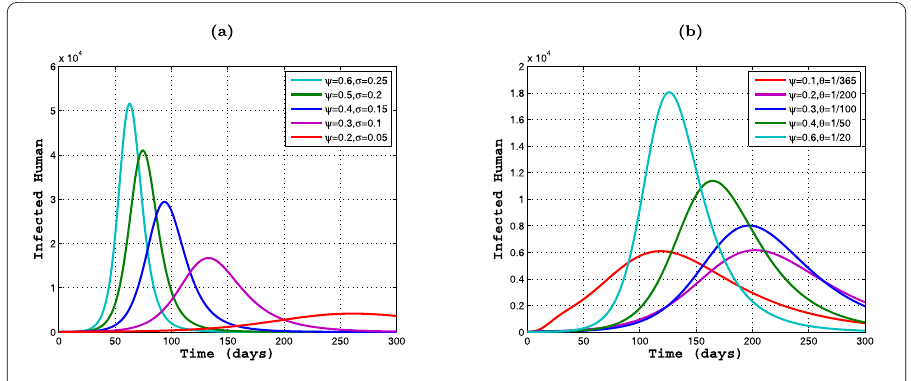
Figure 7 The relationships of ψ and σ , and ψ and θ : (a) ψ = 0.6 and σ = 0.25, ψ = 0.5 and σ = 0.2, ψ = 0.4 and σ = 0.15, ψ = 0.3 and σ = 0.1, ψ = 0.2 and σ = 0.05; (b) ψ = 0.1 and θ = 1/365, ψ = 0.2 and θ = 1/200, ψ = 0.3 and θ = 1/100, ψ = 0.4 and θ = 1/50, ψ = 0.5 and θ =